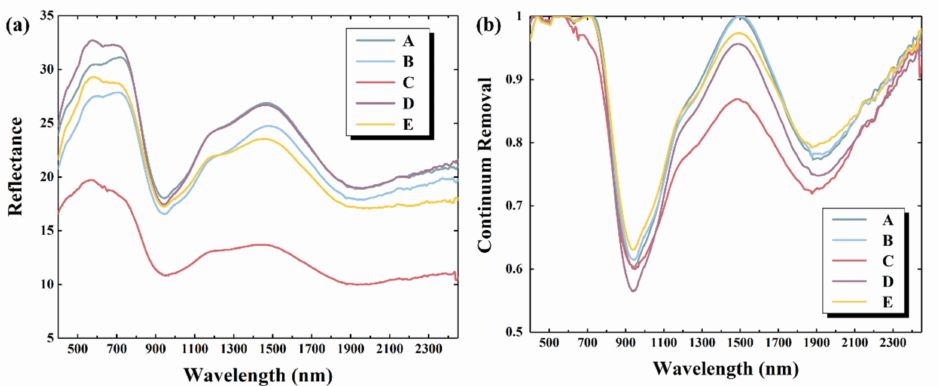
Figure 7. ( a ) Visible and near-infrared (VNIR) reflectance spectra of NWA 8687 chip surface spots marked in Figure 1. ( b ) VNIR spectra after continuum removal.